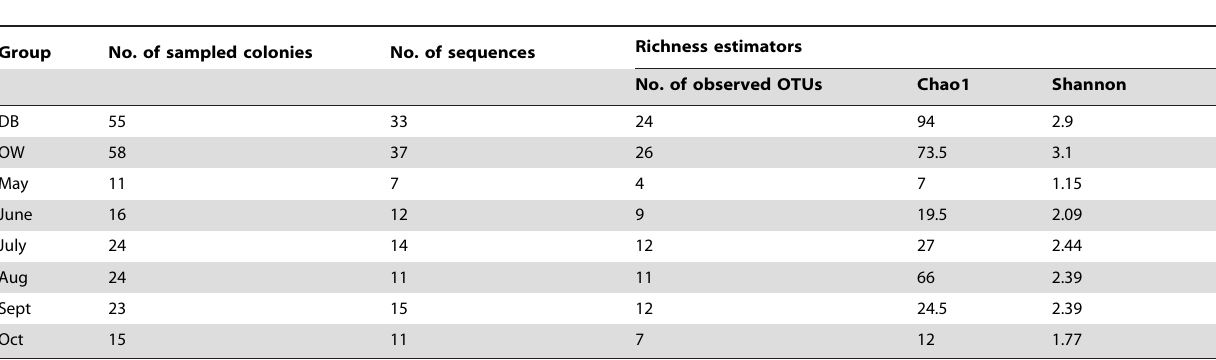
community composition depended on host genotype in the oyster Table 1. Number of OTUs and richness estimators (Chao1 and Shannon-Wiener Index) for each sampling month (May–Oct) as well as at both sampling sites (Dietrichsenbank and Oddewatt) on the basis of 99% identity cut-off.